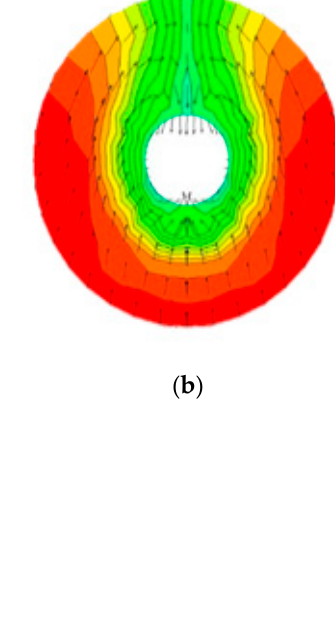
( b ) Figure 7. Comparison of nominal wake between EFD and CFD: ( a ) W n = 0.452 (EFD); ( b ) W n = 0.440 (CFD) [25]. As mentioned before, the aft-body hull form of a slow-speed ship has recently been made slender, even similar to that of container ships. This recent trend is specifically shown in Figure 8, where the tanker’s mean wake becomes smaller, being less than 0.5 (the present case is 0.452) approximately 5 years ago, while the mean wake of a slow- speed full-body ship (176K bulk carrier) was 0.623 approximately 15 years ago. Recently, the mean wake has become less than 0.4, which is more similar to that of the container ship. As the stern shape becomes slender, it is difficult to apply ESD. This is because the drag generated by ESD increases and a minor radial flow makes the application of the duct difficult. According to this trend, the duct should be smaller or absent to minimize